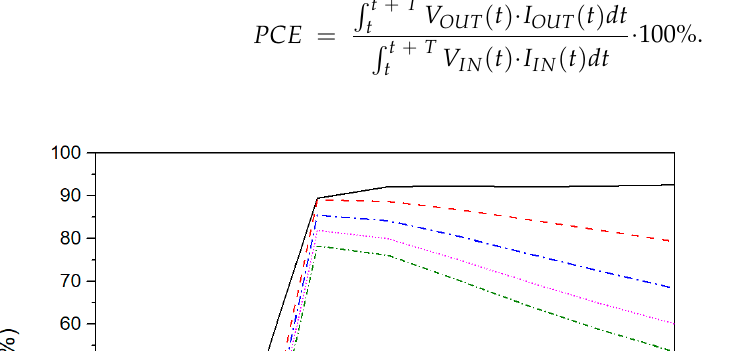
Figure 6. Simulated comparator behavior in steady state for R (cid:2896)(cid:2899)(cid:2885)(cid:2888) = 500 Ω and C (cid:2896)(cid:2899)(cid:2885)(cid:2888) = 2 µF .